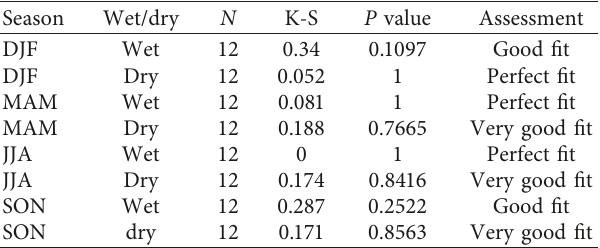
Table 6: Results of the K-S test: goodness of fit comparison between two time series of observational rainfall data and the simulation of the Doroudzan station.